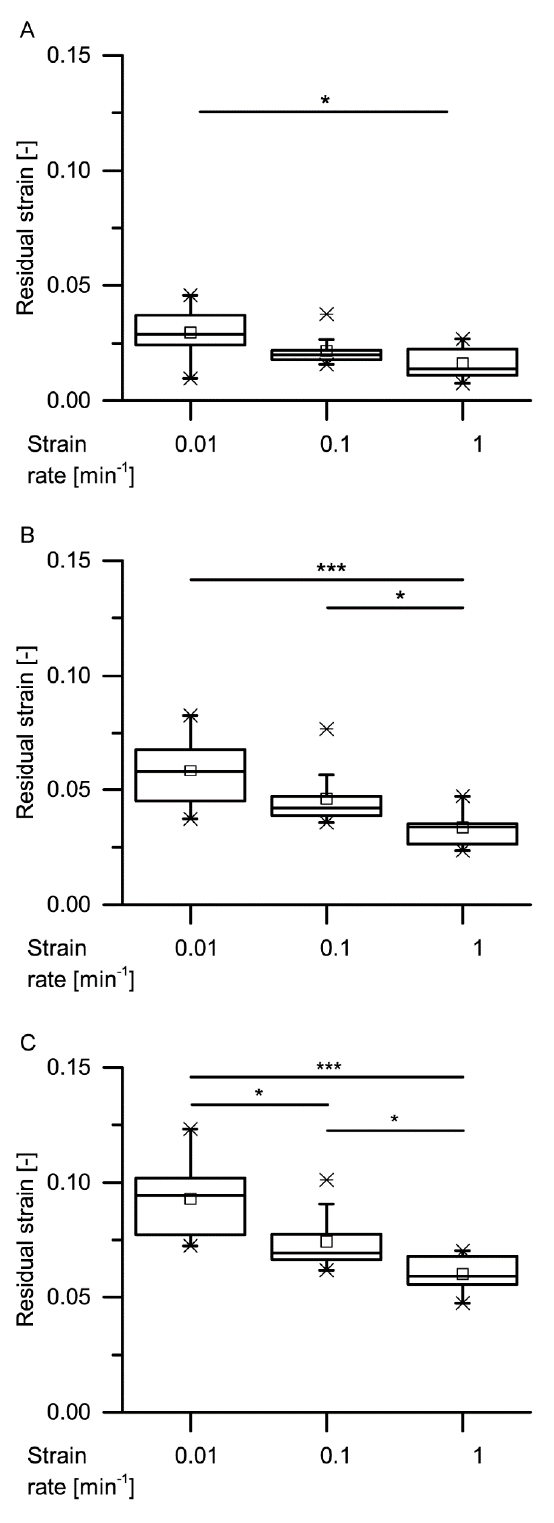
Figure 10. Residual strains of the first ( A ), second ( B ) and third ( C ) cycles of the quasistatic stepwise cyclic compressions tests, at several strain rates (statistical test: Kruskal–Wallis test; n = 10 for each group). Significant di ff erences are marked by asterisks, with the levels of significance indicated as follows: * p < 0.05, *** p <